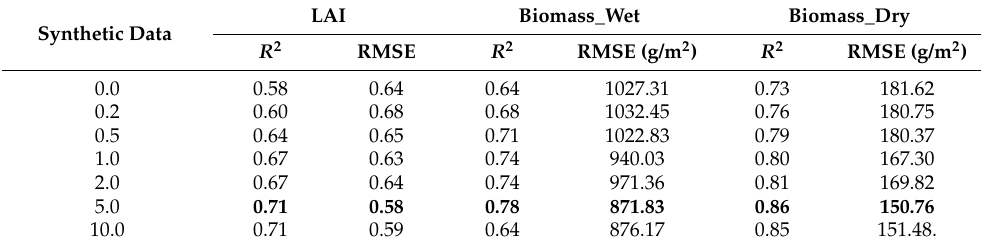
Table 6. Influence of the amount of synthetic data in mixup + on the inversion accuracies of the LAI and